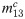
Summary of model comparison.Top: Summed LME of all subjects for all 30 models. White bars show models with all parameters free, grey bars models with constrained parameters. LMEs are normalized by subtracting the lowest LME (m5). Model m13c (constrained SERIAlr) exceeded all other models (ΔLME > 200). Bottom: Illustration of model probability for all subjects. The posterior model probabilities for all subjects are shown as black dots. In white shading are models with all parameters free, grey bars represent models with restricted parameters. Note that in nearly all subjects, the SERIAlr models with restricted parameters showed high model probabilities.